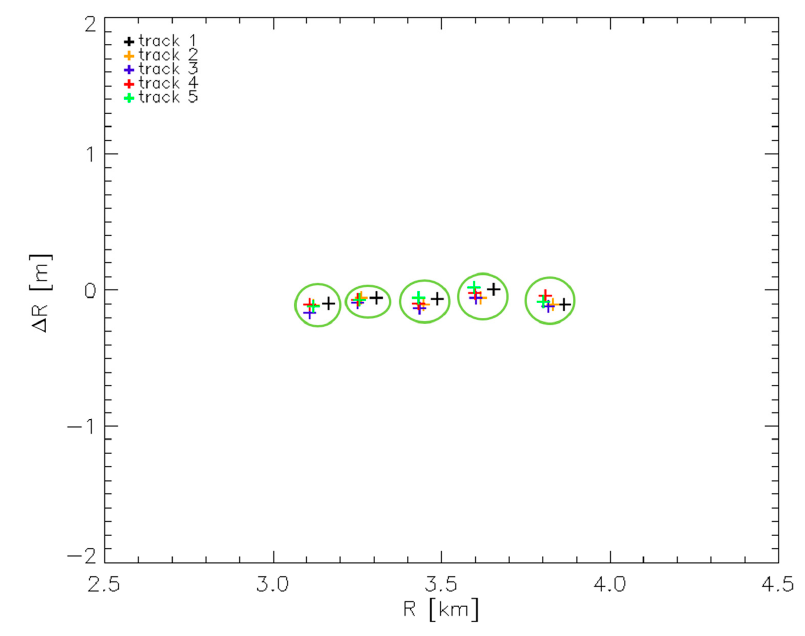
Figure 9. As Figure 8, but using the SAR images focused by using the FSR estimated in the Experiment 5.